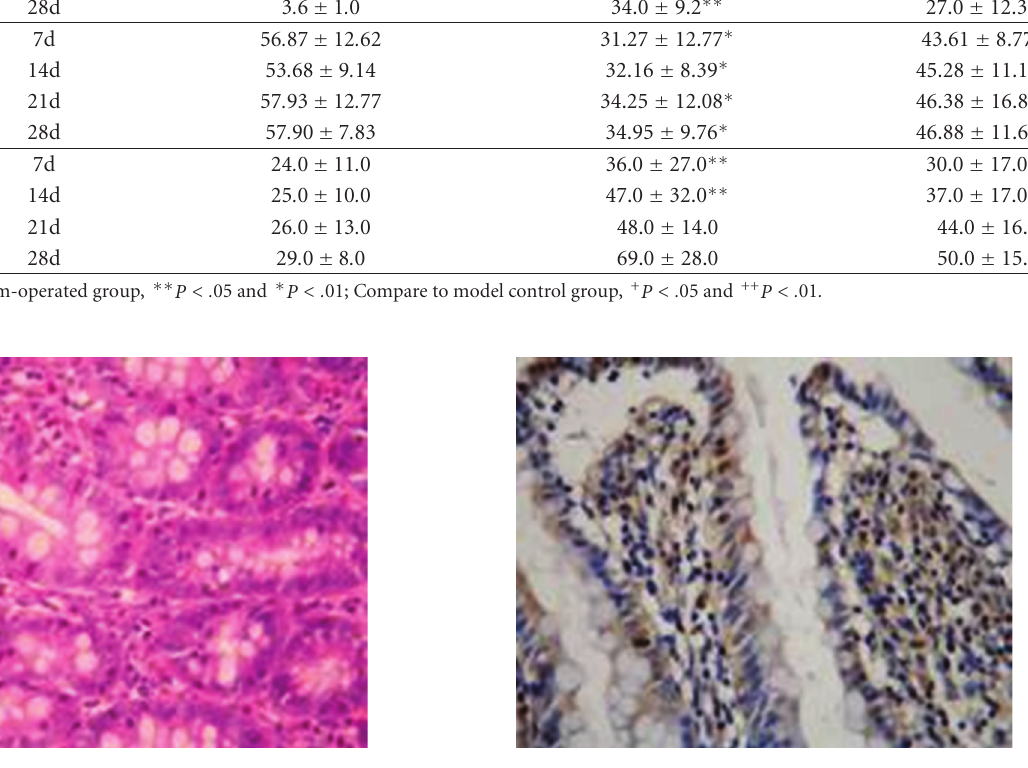
Figure 4: Treated group-28d mucous membrane of small intestine is approximately normal HE × 200.